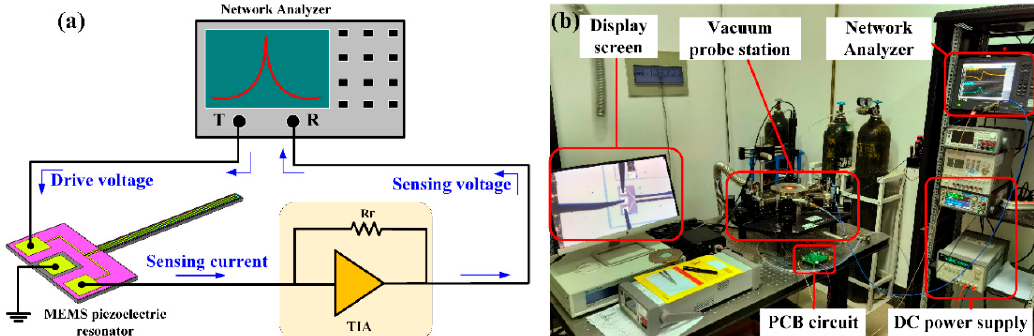
Figure 5. The schematic of the open ‐ loop electrical measurement setup. ( a ) The drive voltage generated by a Network Analyzer is applied in the driving electrode (left); the middle electrode connects the ground; then, the sensing current generated in the sensing electrode (right) was fed to the transimpedance amplifier (TIA), which consists of an operational amplifier and a feedback resistance, transforming the current into voltage; finally, the sensing voltage is fed to the Network Analyzer. The Network Analyzer will automatically display the transmission curve, as shown in Figure 6. The blue arrows represent the signal flow; ( b ) the actual measurement setup, whereby the piezoelectric cantilever is inside the vacuum probe station, which is amplified by the microscope and is shown in the display screen. The black probes in the display screen are sensing, driving, and ground electrode.